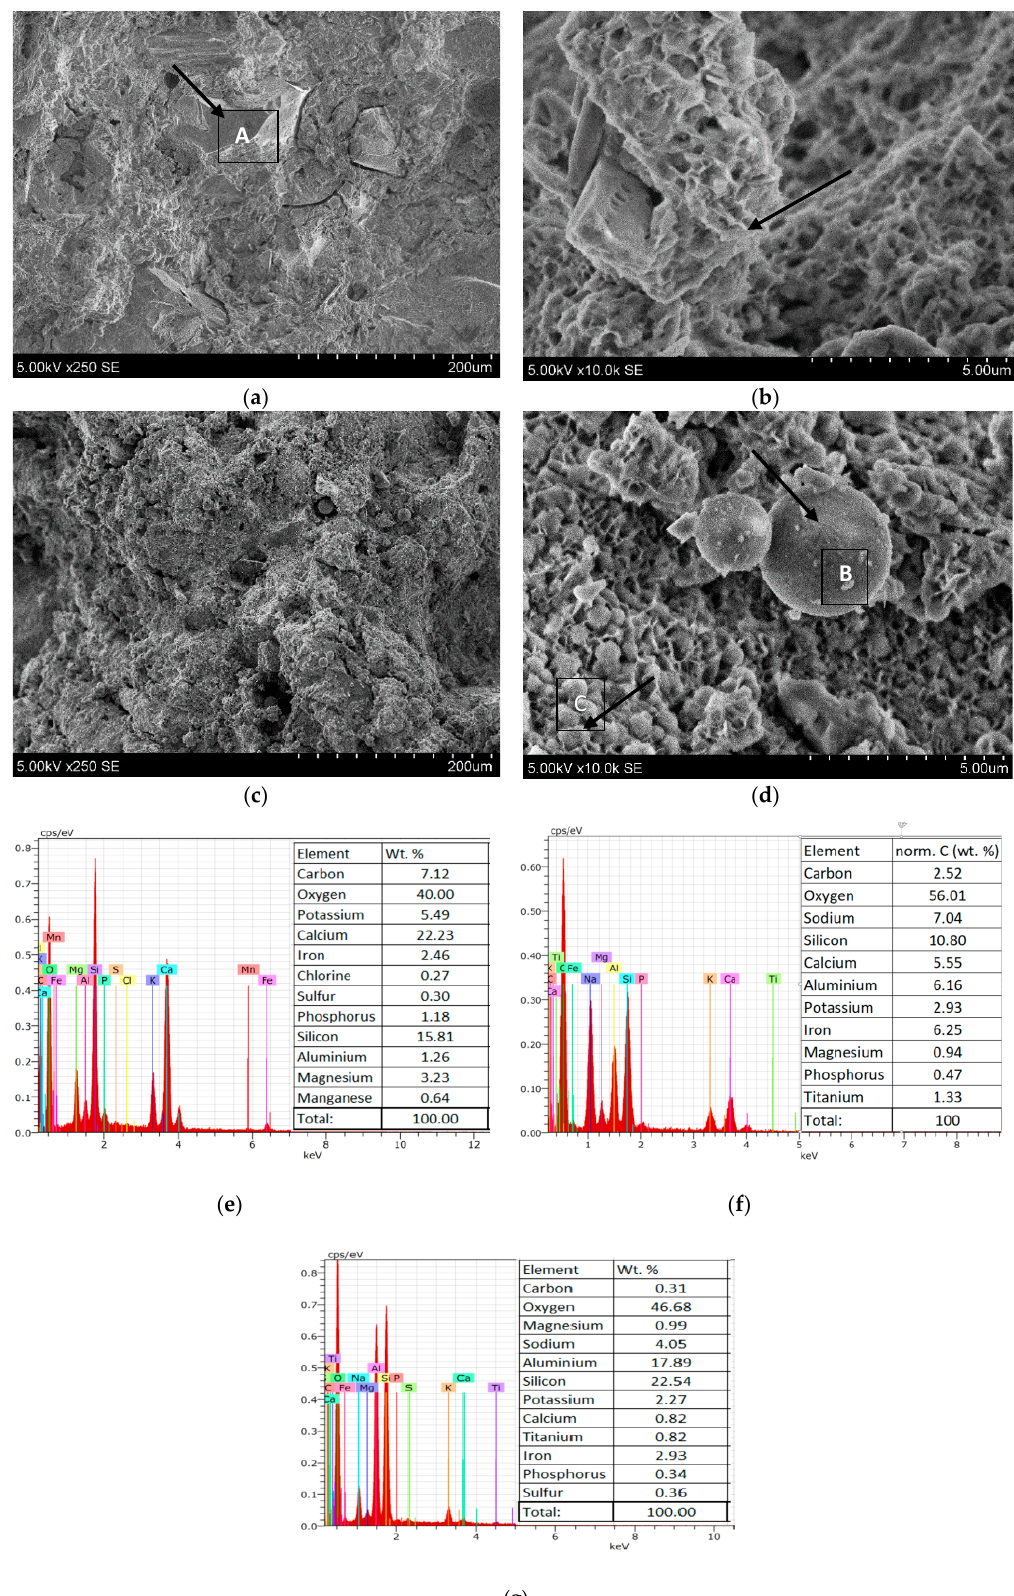
Figure 2. Microstructures of the alkali-activated biomass bottom ash without ( a , b ) and with 15% of zeolitic waste ( c , d ) and the EDX spectra ( e , f,g ).